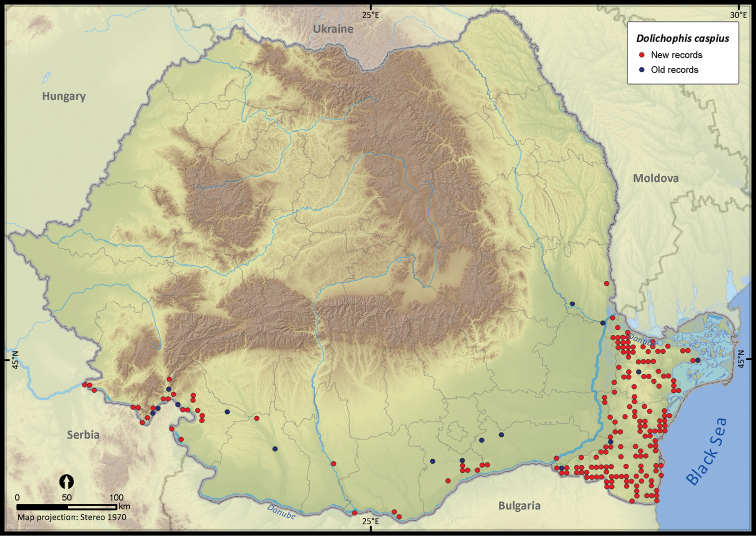
Dolichophis caspius.